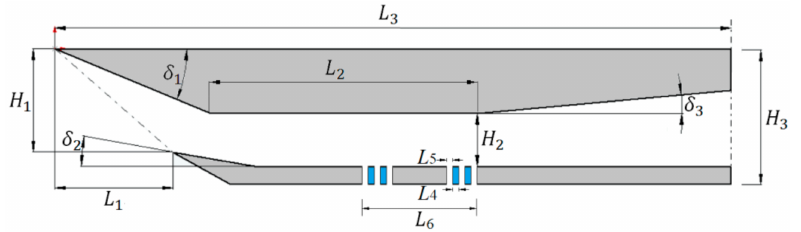
Figure 1. Inlet geometric model.